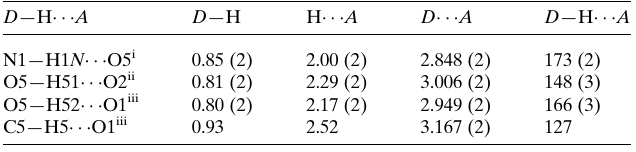
Table 3 Hydrogen-bond geometry (A˚ , (cid:4) ) for (III).